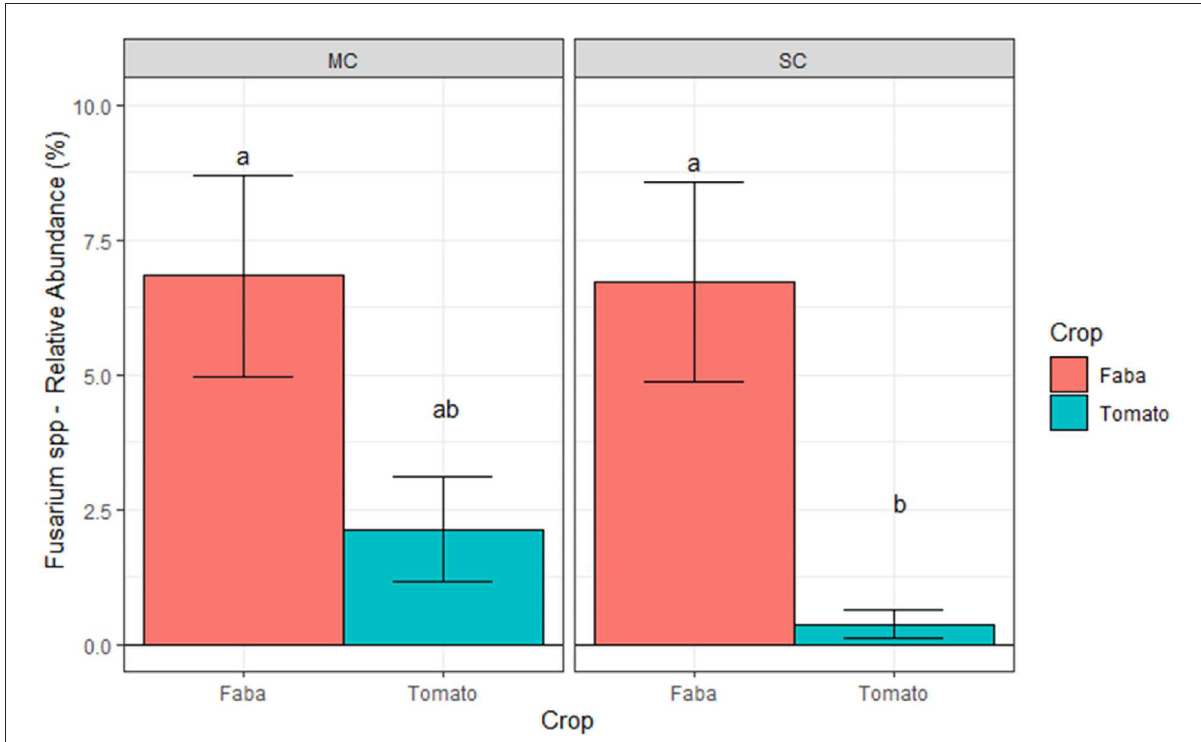
FIGURE9 Relative abundances of Fusarium spp. at CREA site averaged across blocks. Bars denote standard errors of the mean. Different letters are significantly different at p < 0.05 (Tukey test). MC, Monocropping; SC, Strip